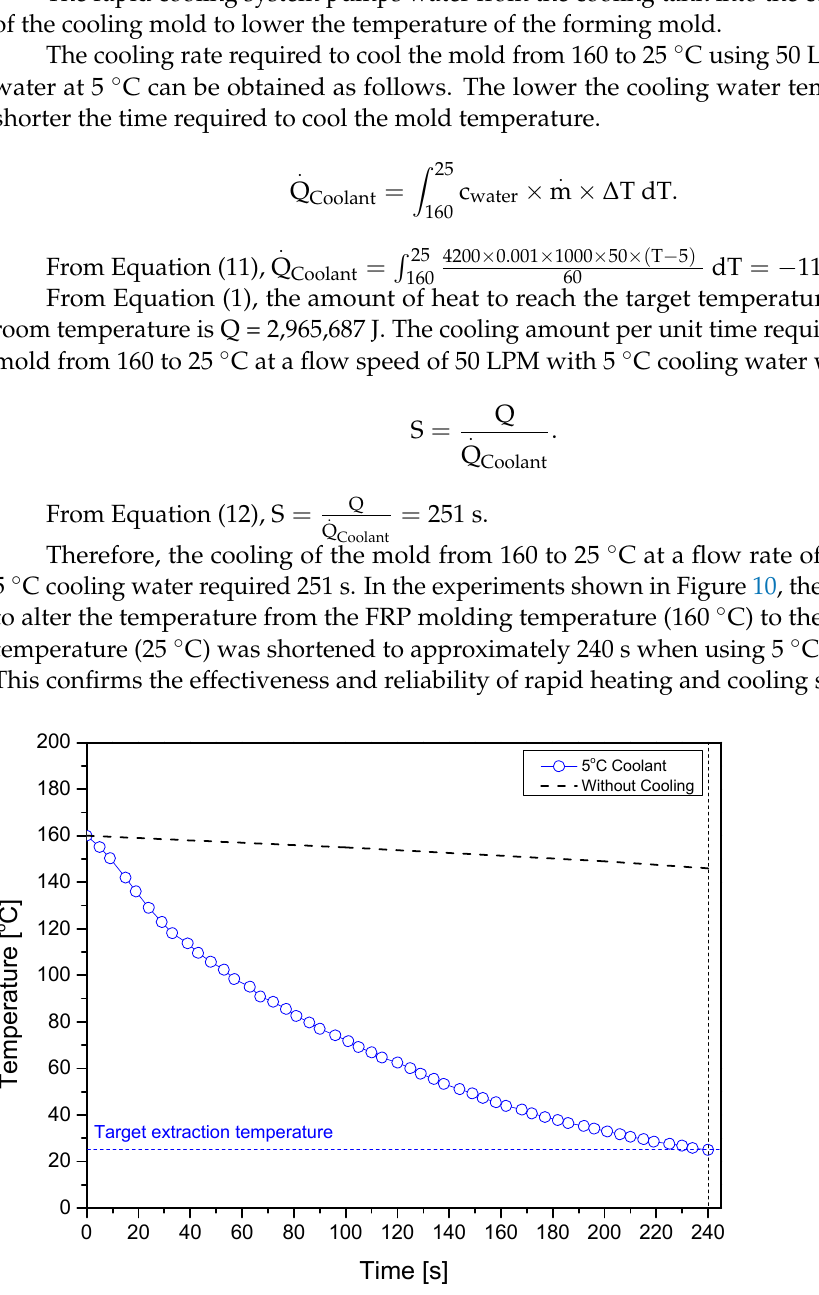
Figure 10. Cooling temperature profile of the rapid heating and cooling system.